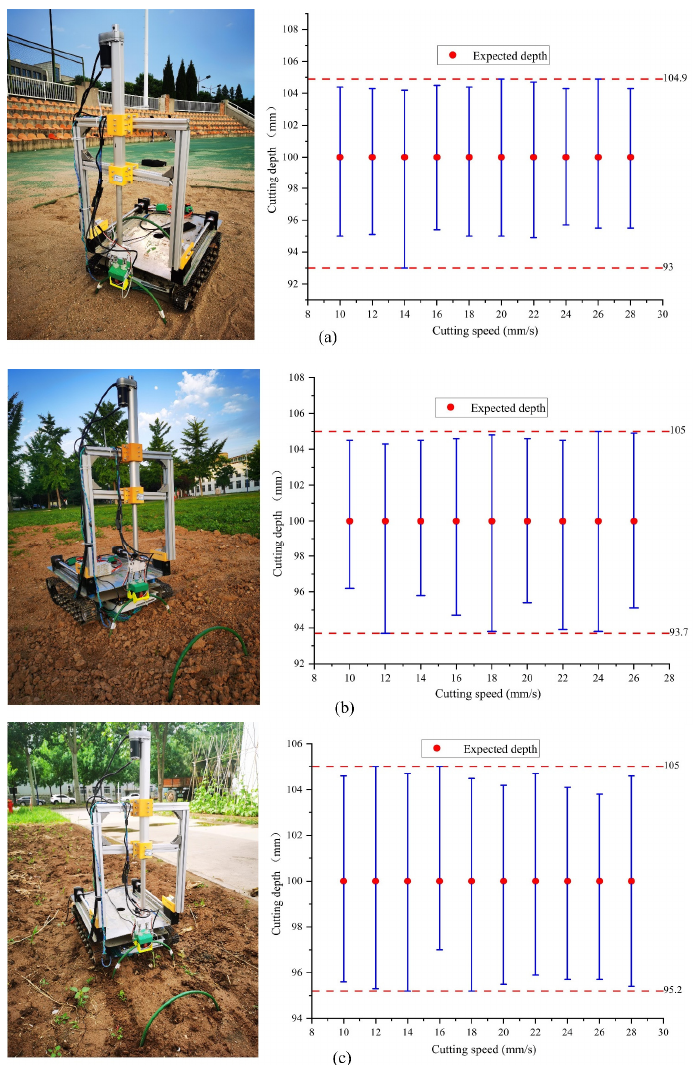
Figure 17. Error bar charts for the cuttage depth. Note that ( a ): Sandy soil experiments; ( b ): dry soil experiments; ( c ): wet soil experiments. experiments; ( c ): wet soil